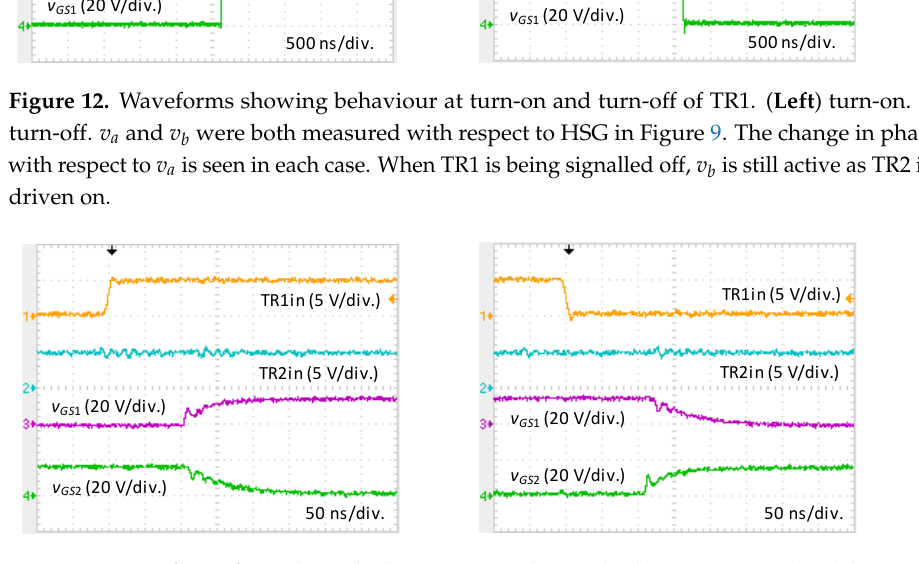
Figure 13. Waveforms from channels driving TR1 and TR2. ( Left ) TR1 turn-on. ( Right ) TR1 turn-off.